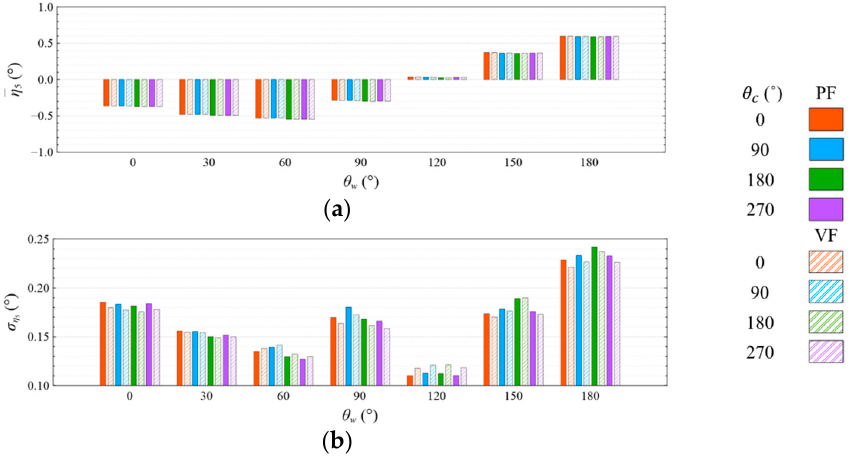
Figure 25. Comparison of ( a ) means and ( b ) standard deviations of platform pitch motion under HW condition.